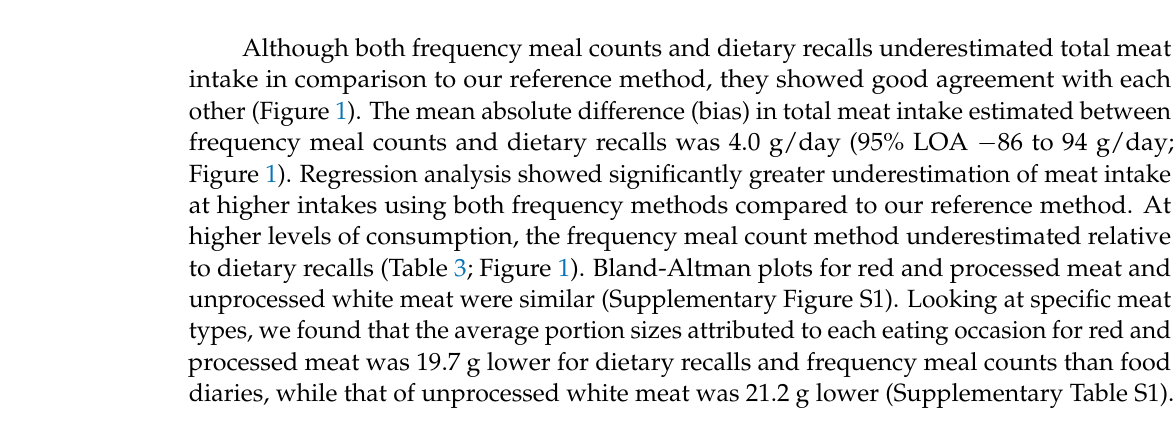
Table 3. Linear regression analyses for magnitude bias for estimating meat intake obtained by disaggregated food diaries, frequency meal counts and dietary